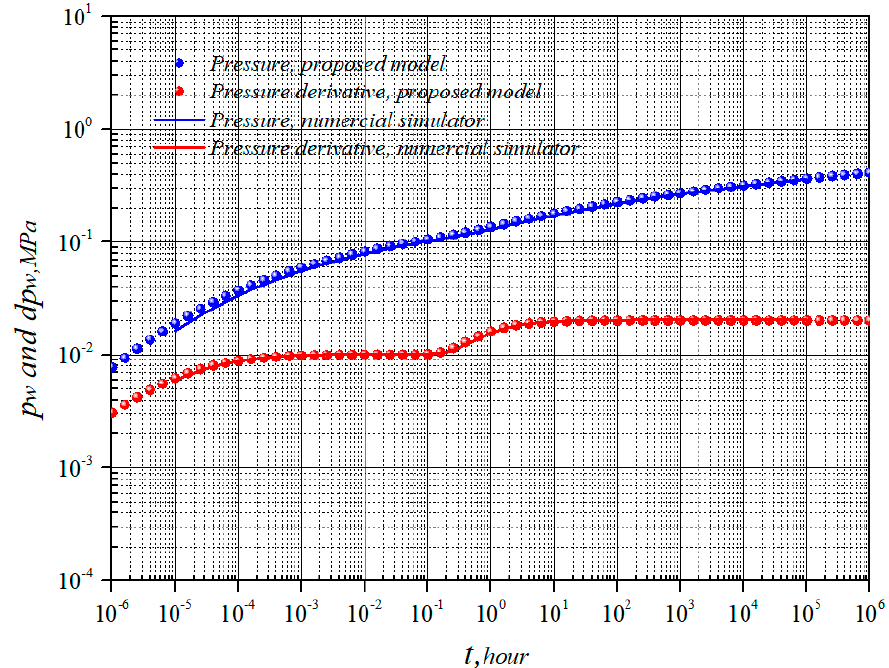
Figure 2. Comparison of the proposed model and numerical simulator for the homogeneous model case 1.